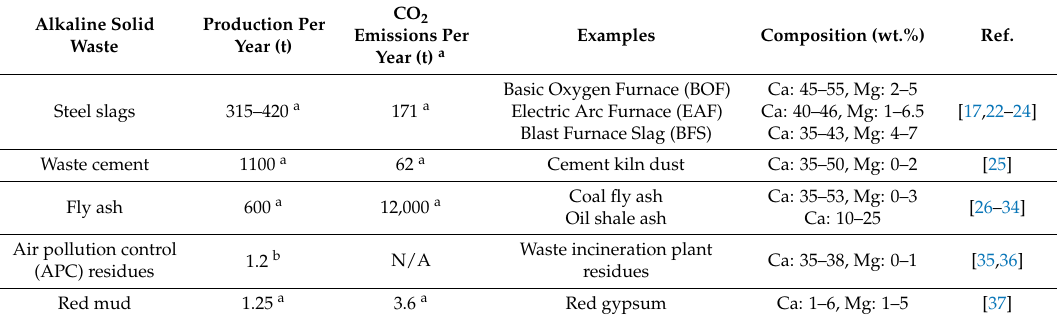
Table 3. Alkaline solids studied in the literature, their composition and global production per year and the CO 2